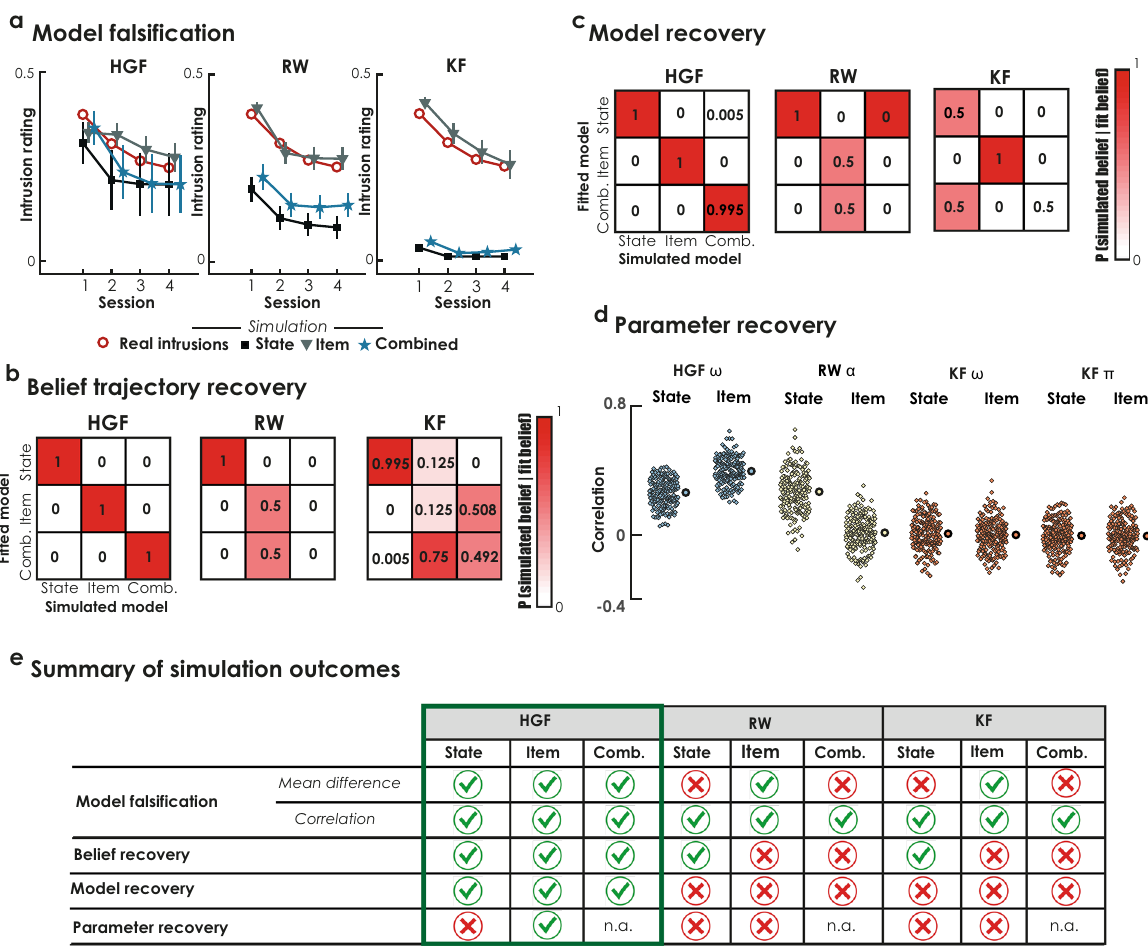
Fig. 2 Validation of computational models. a Model falsi fi cation. In order to test the models ’ generative performance (i.e., the model ability to generate plausible data), we generated synthetic intrusion data for each model, simulating 200 virtual participants for which we repeated the simulations 100 times (so 20,000 simulations in total). We reported the session-wise mean trajectories of real intrusions rating (empty red circles) and simulated intrusions data, under HGF, RW and KF models, for both state (black squares), item (gray triangles), and combined (blue stars) sources model versions. Error bar represents 95% con fi dence intervals of the virtual participants ’ distribution. b Belief recovery. Inversion matrix re fl ecting the con fi dence that the beliefs fi tted by a given model was the model that most likely has generated those beliefs. c Model recovery. Inversion matrix re fl ecting the con fi dence that the best fi tting model has generated the data. d Parameter recovery. Correlation between fi tted and simulated model parameter for each virtual participant and each model. The large dot at the right of each distribution represents the mean correlation across virtual participants. e Summary of simulation